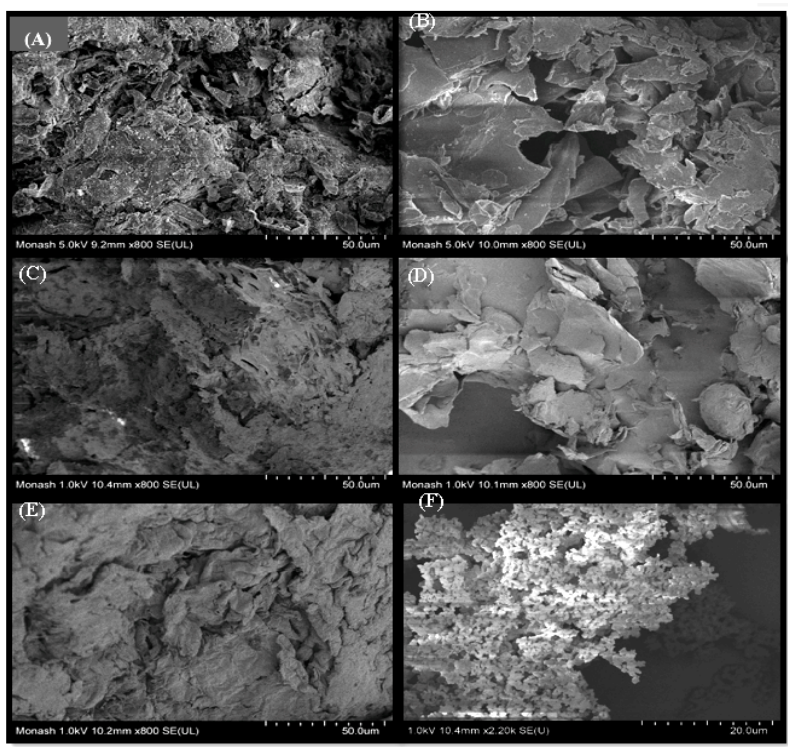
Figure 5. FE ‐ SEM images of cellulose A (preparation 1) ( A ); cellulose B (preparation 2) ( B ); cellulose C (preparation 3) ( C ); cellulose D (preparation 4) ( D ); cellulose E (preparation 5) ( E ); and carboxymethyl sago cellulose (CMSC) ( F ). All cellulose preparation was at ×800 magnification and CMSC was at 2200× magnification.